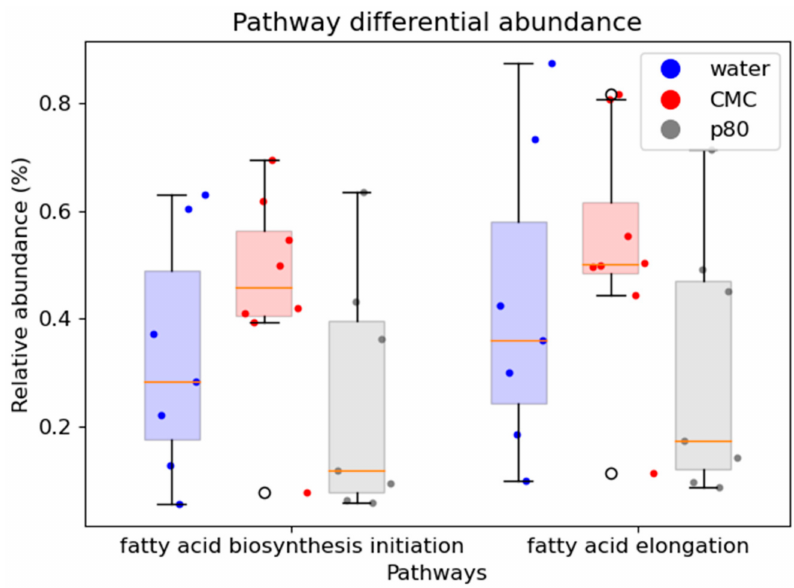
Figure 7. The effect of the CMC (1% w / v , red), P80 (1% v / v , gray), and water (control, blue) on select metabolic pathways. CMC illustrates a clear trend toward increased fatty acid biosynthesis initiation and elongation compared to P80 and water treatment. Medians and interquartile ranges are provided for each